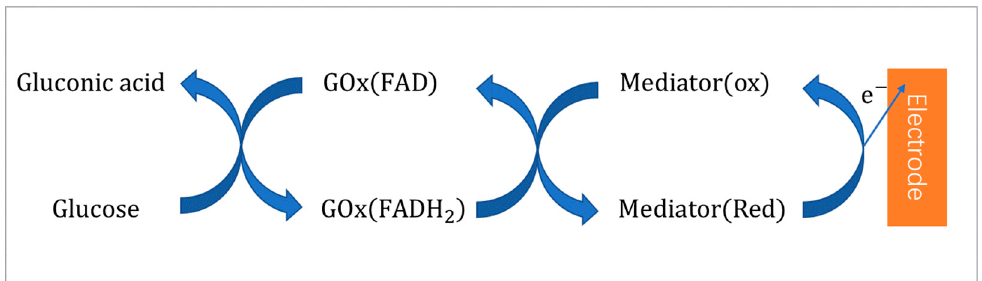
Figure 2. Schematic diagram of the second-generation glucose biosensor.